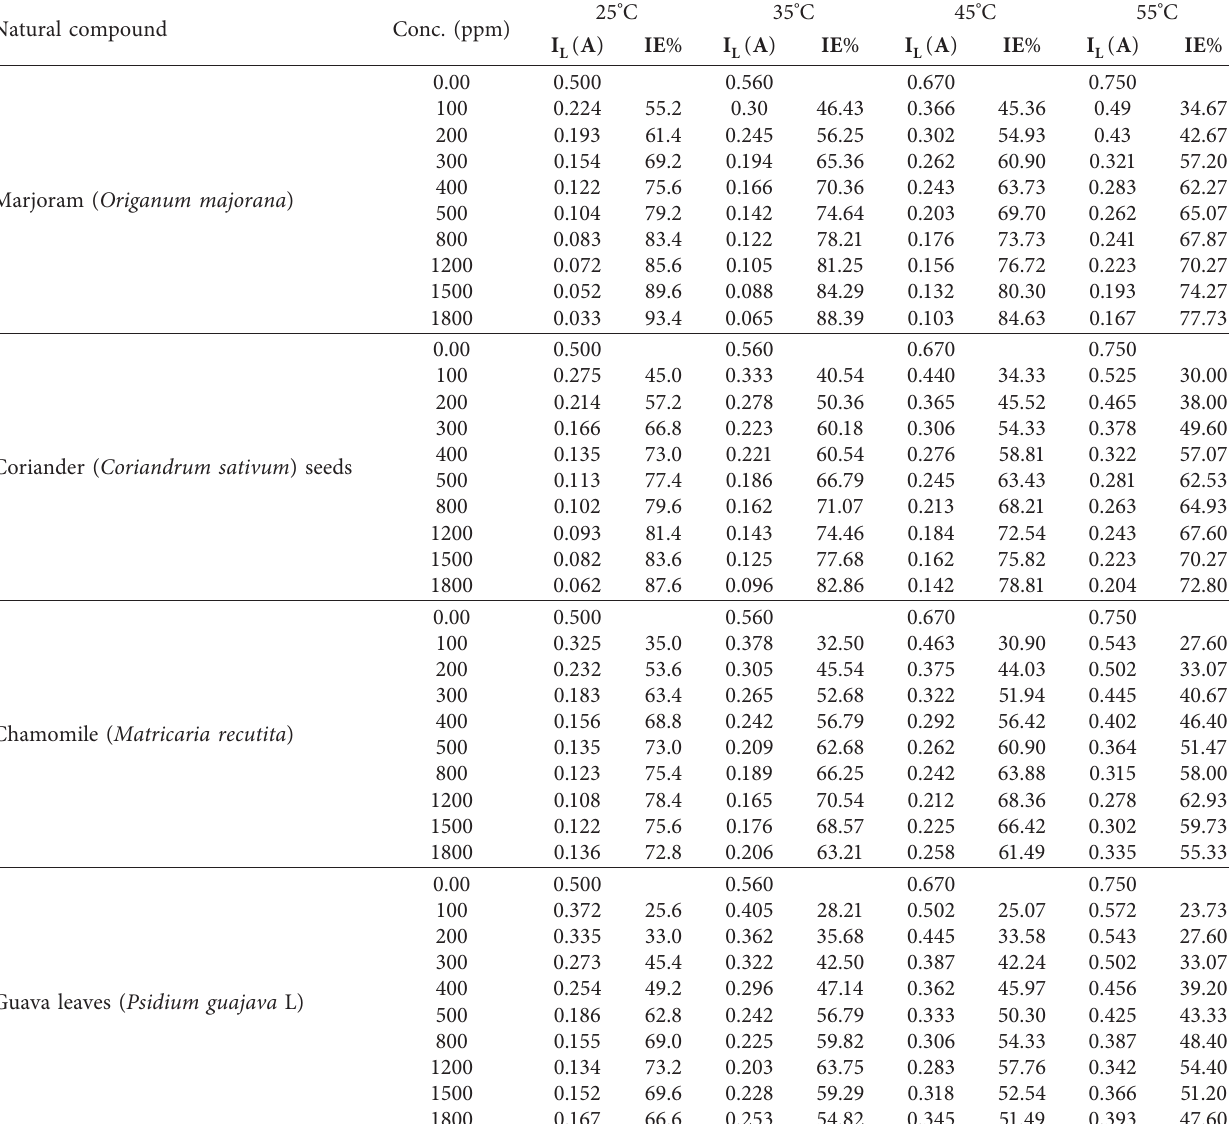
3 PO 4 acid in the absence and presence of natural extracts at several